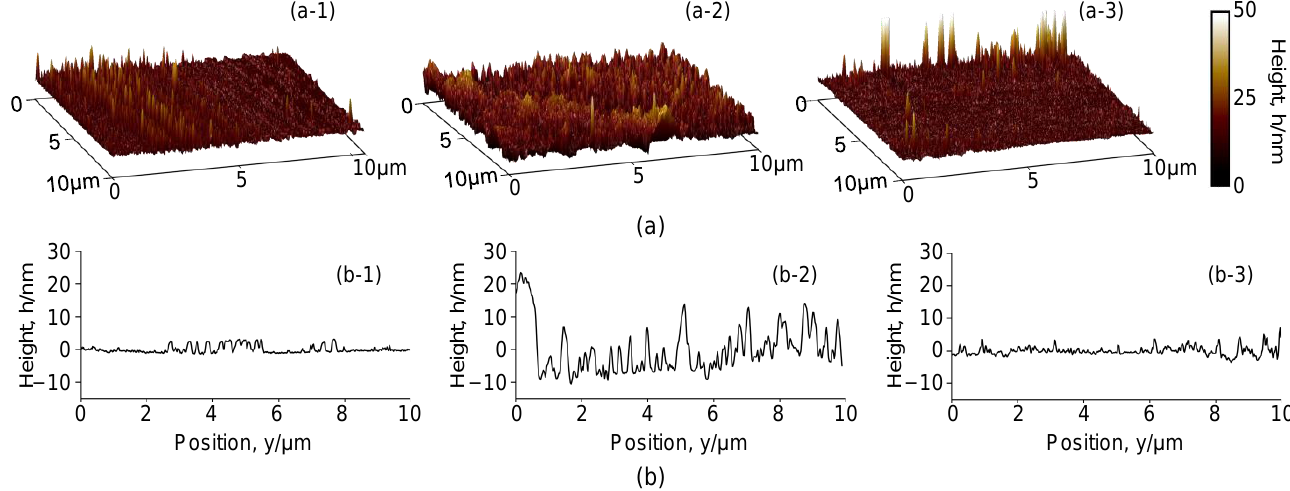
Figure 13. ( a ) Raman spectra of Fe 80 Si 9 B 13 samples before and after W-EDM, showing char- acteristic peaks of iron oxide and oxyhydroxide phases. ( b ) XPS spectra of Fe 80 Si 9 B 13 ribbons before W-EDM ( b-1 ) and after W-EDM ( b-2 ), showing characteristic peaks of iron oxide and oxyhy- droxide phases.